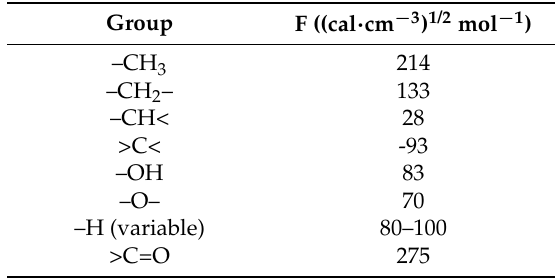
Table 3. Small’s molar attraction constants for some functional groups